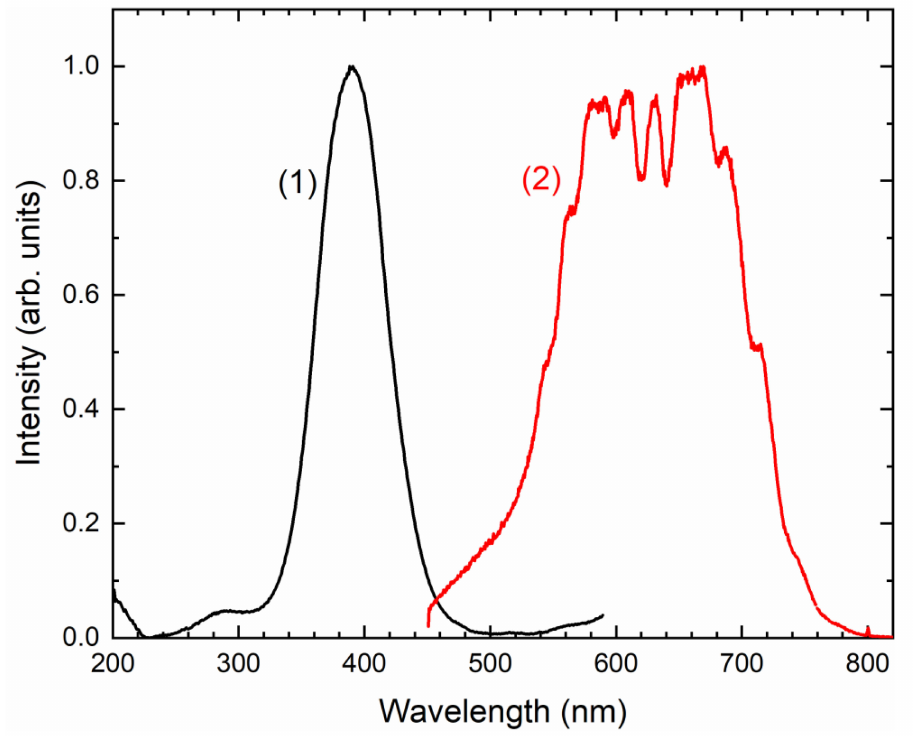
Figure 18. Excitation spectrum of tugtupite monitored at 605 nm (curve 1) and luminescence spectrum of tugtupite monitored at 400 nm (curve